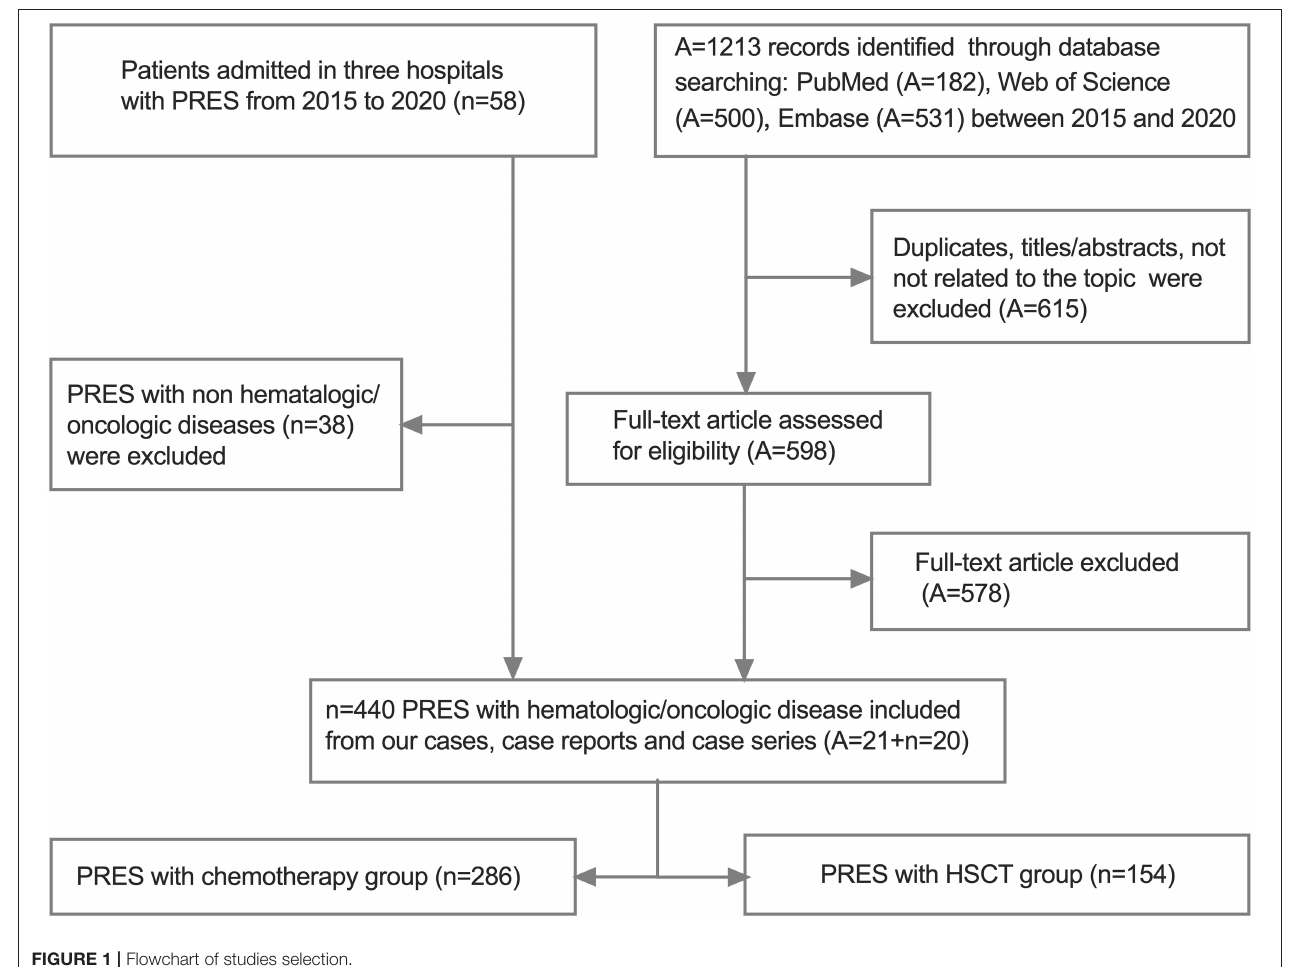
FIGURE 1 | Flowchart of studies